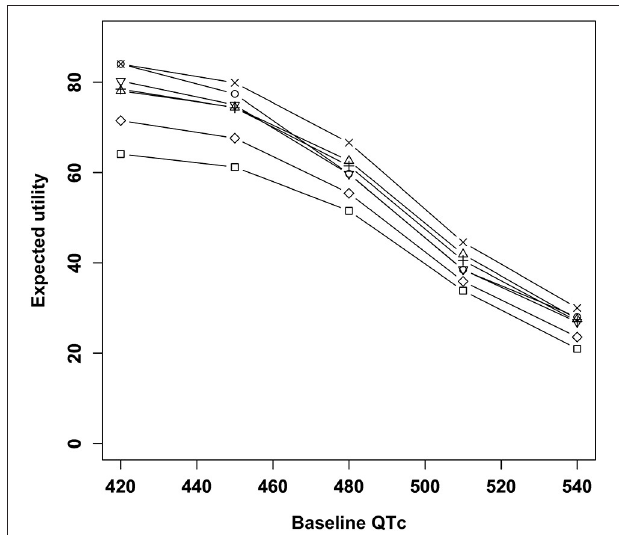
FIGURE 2 | Expected utility of antipsychotics according to baseline QTc intervals. 2 , Placebo; ◦ , Amisulpride; 1 , Haloperidol; +, Olanzapine; × , Quetiapine; ⋄ , Risperidone; ∇ ,